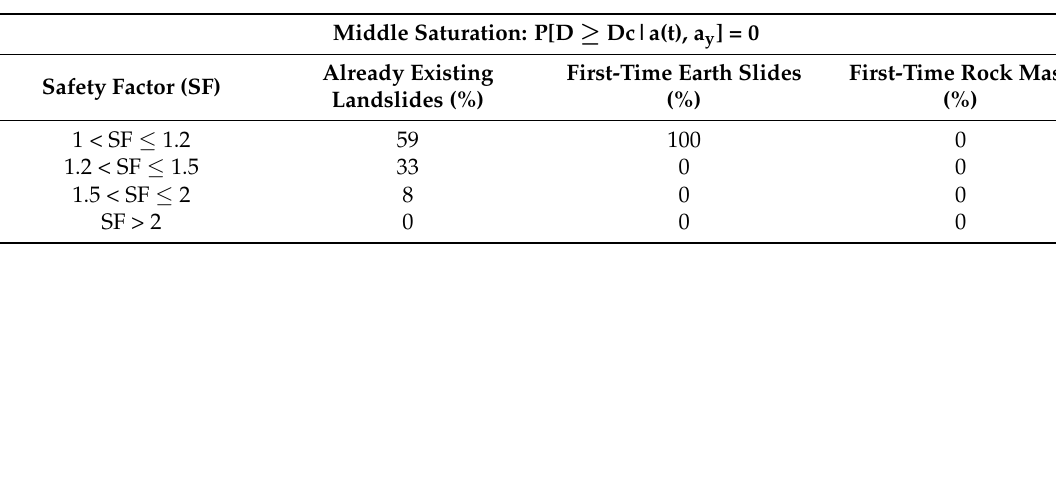
Table 6. Safety factor values computed in the middle saturations scenario for different landslide